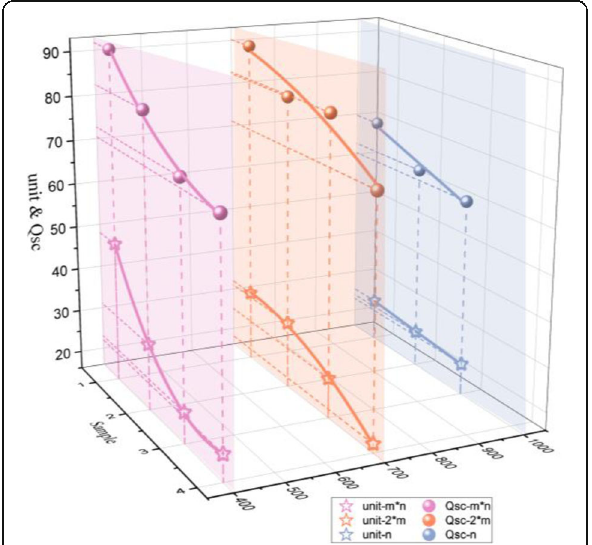
Fig. 4 The output performance changed through the number of the convex